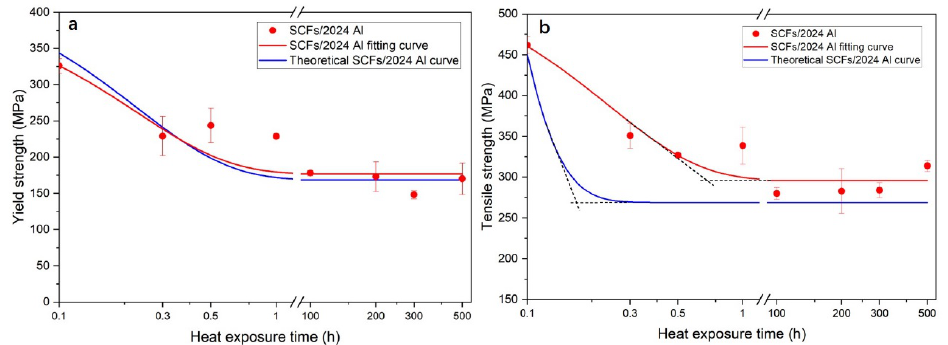
Figure 15. ( a ) Yield strength actual value fitting curve and theoretical curve; ( b ) Tensile strength actual value fitting curve and theoretical curve.